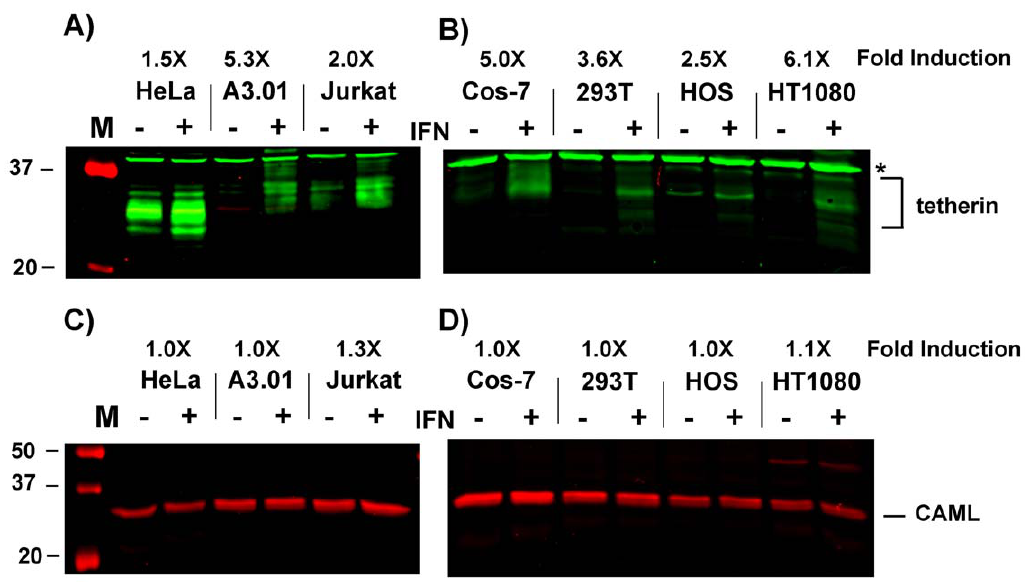
Figure 1. Tetherin is interferon-inducible; CAML is not interferon-inducible. A) Western blot for endogenous tetherin was performed using rabbit polyclonal antisera before or 48 hours after interferon-induction. Note that induction was demonstrated in each case, and baseline levels of tetherin were highest in HeLa cells. Lanes were normalized by total protein quantitation. D) Western blotting for endogenous CAML was performed in the same panel of cells. Note that no induction was demonstrated, and all cell types expressed detectable CAML. Cell lines are indicated above the blots, and IFN treatment is indicated with a plus sign. M = molecular mass markers.